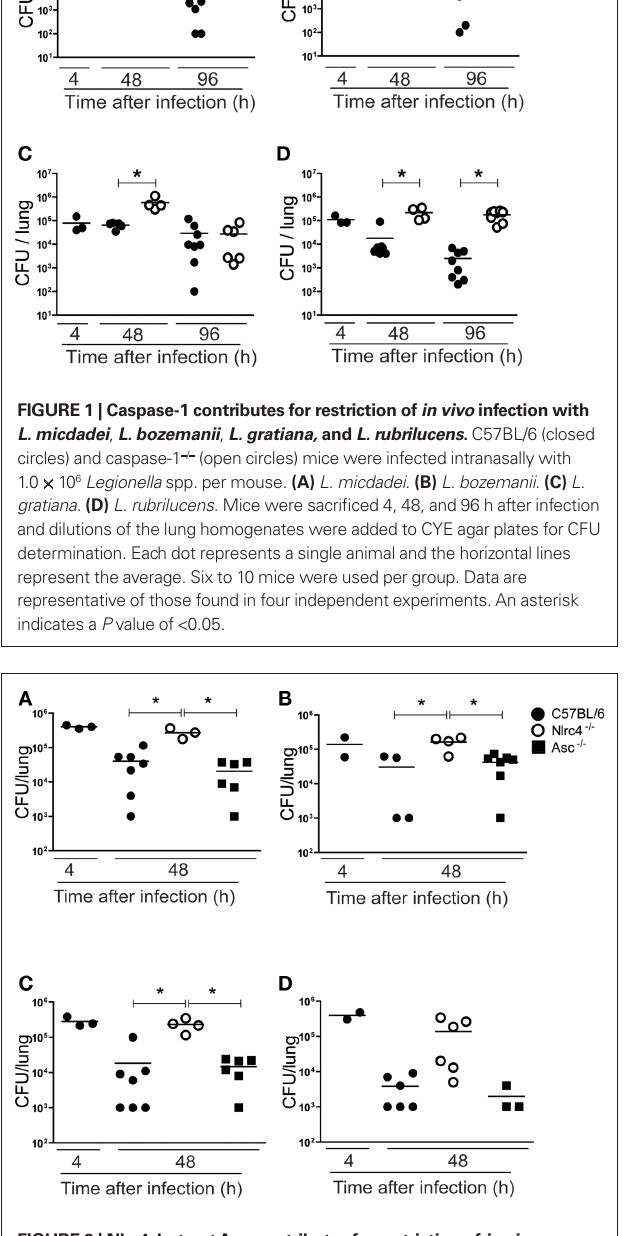
Figure 2 | Nlrc4, but not Asc, contributes for restriction of in vivo infection with L. micdadei , L. bozemanii , L. gratiana, and L. rubrilucens . C57BL/6 (closed circles), Nlrc4 − / − (open circles), and Asc − / − (closed squares) mice were infected intranasally with 1.0 × 10 6 Legionella spp . per mouse. (A) L. micdadei . (B) L. bozemanii . (C) L. gratiana. (D) L. rubrilucens . Mice were sacrificed 4 or 48 h after infection and dilutions of the lung homogenates were added to CYE agar plates for CFU determination. Each dot represents a single animal and the horizontal lines represent the average. Three to 10 mice were used per group. Data are representative of those found in three independent experiments. An asterisk indicates a P value of < 0.05.